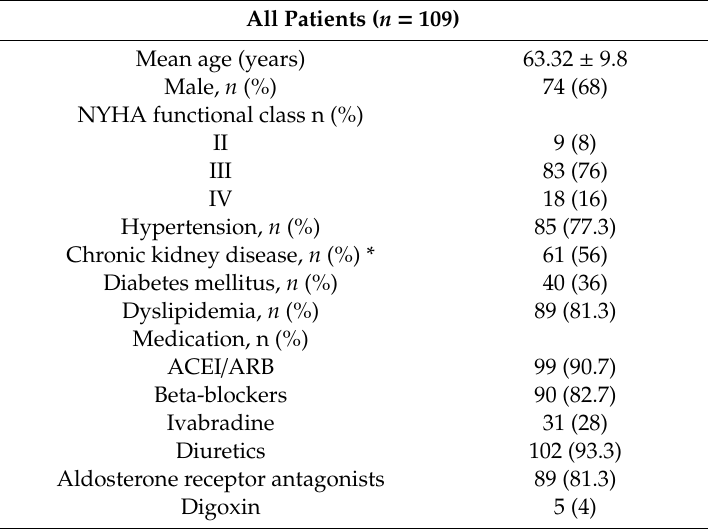
Table 1. Baseline demographic